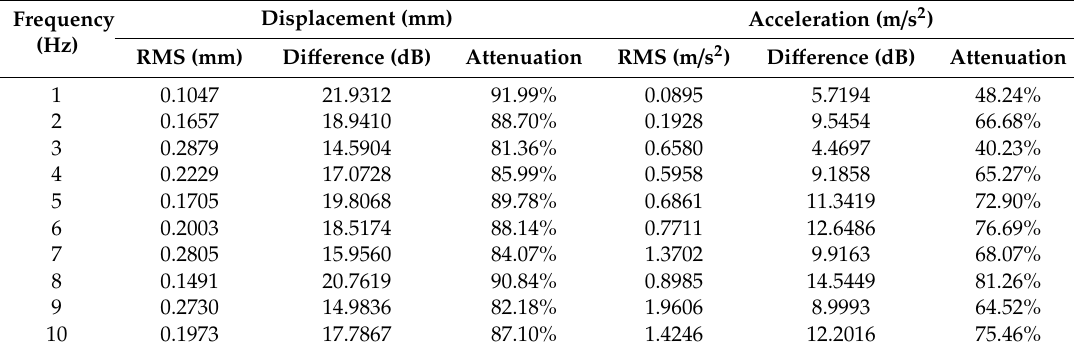
Table 2. Vibration response of pipeline under two-state pipeline vibration